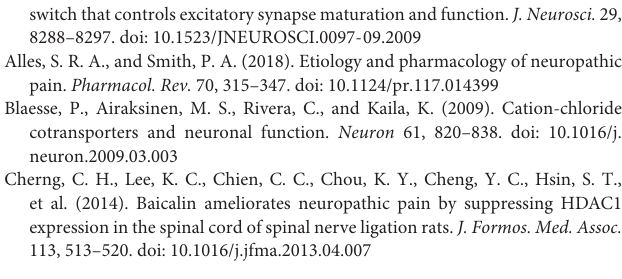
FIGURE S1 | Suppressing HDAC2 by TSA (A) or LV-shRNA-HDAC2 (B) did not affect the motor function of rats. FIGURE S2 | The number of HDAC2 positive cells was increased time-dependently in the ipsilateral dorsal horn of CCI rats. Kruskal–Wallis test with Dunn’s post-test was used, n = 4 per group, ∗ p < 0.05, compared with the sham group (Kruskal–Wallis statistic = 17.90, P = 0.0031; multiple comparisons: sham vs. D7, 316.8 ± 9.928 vs. 440.8 ± 13.89, p = 0.0296; sham vs. D14, 316.8 ± 9.928 vs. 462.5 ± 24.94, p = 0.0145; n = 4 for each group). FIGURE S3 | The immunohistochemical image showed an increase of HDAC2 in the ipsilateral dorsal horn (marked by arrow) of CCI rats at the 10th day after